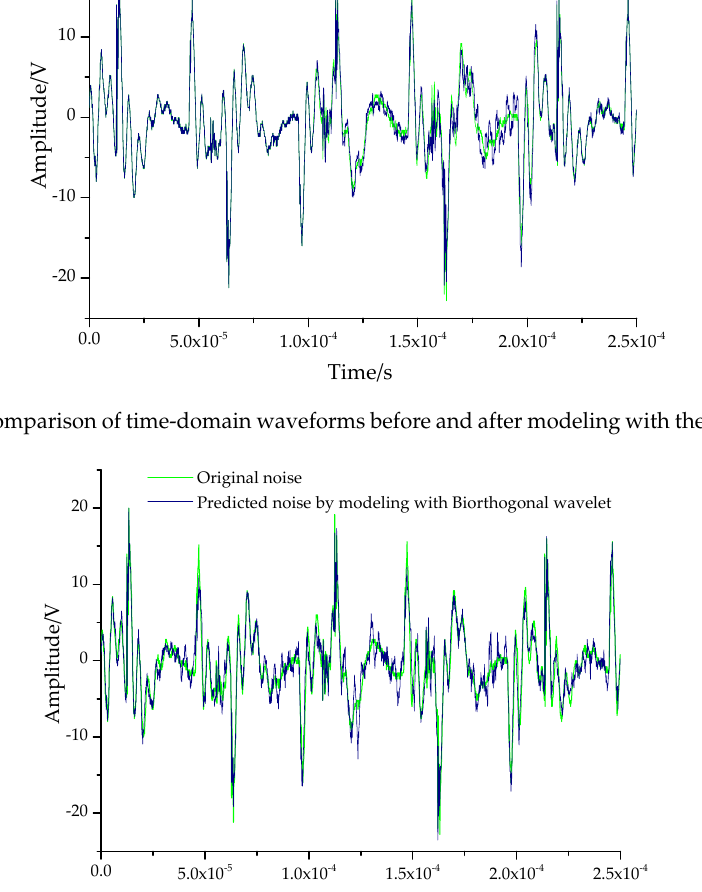
Figure 9. The comparison of time-domain waveforms before and after modeling with biorthogonal wavelet.